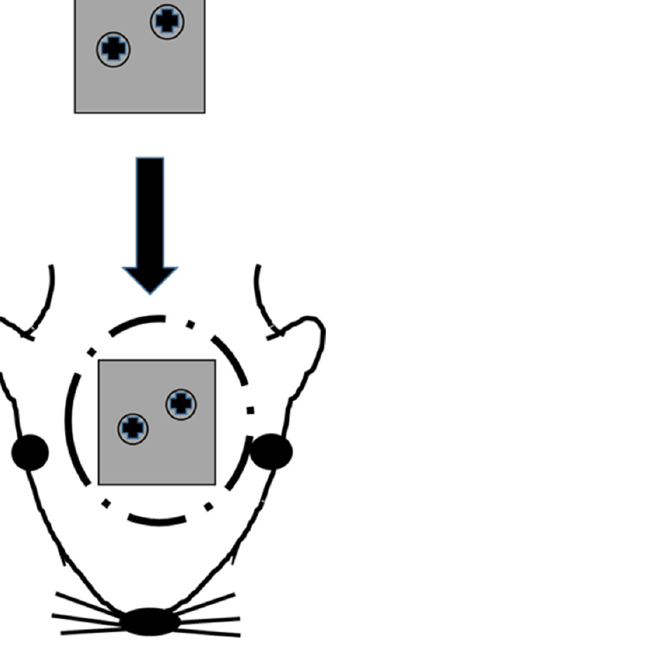
Figure 2. Implantation technique. The AM Ti plate is fixed to the calvarial bone.